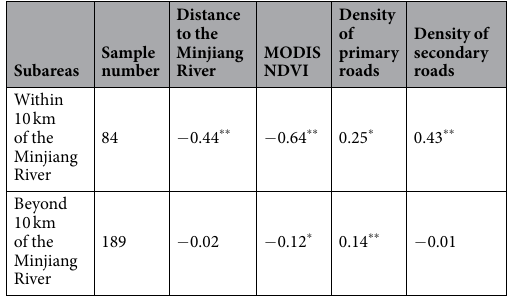
Table 2. Relationships between soil Cd content and the factors in different subareas.